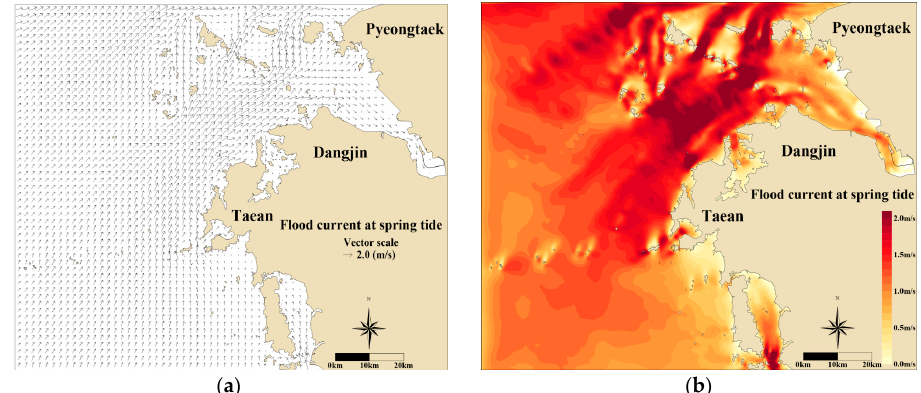
Figure 10. Flood current at spring tide in the surface layer at ( a ) temporal current velocity vector and ( b ) contour plot.